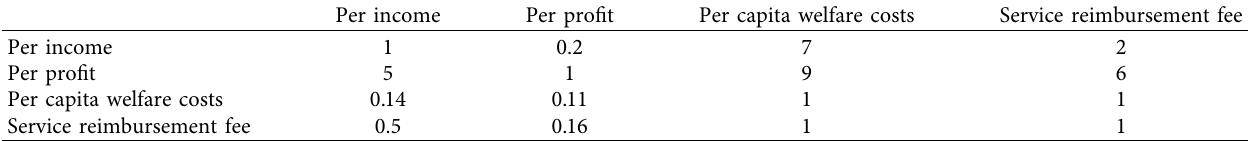
Table 2: Basic table of analytic hierarchical process in financial perspective.